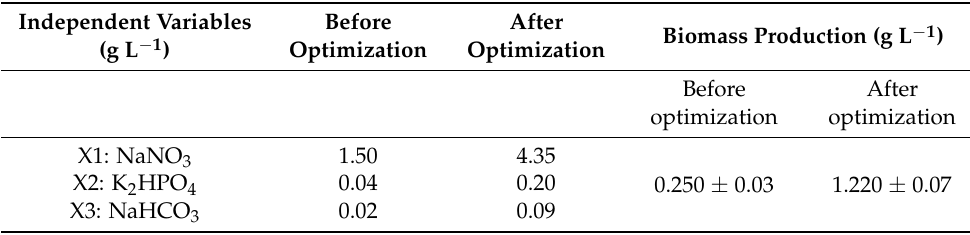
Table 3. First-stage biomass optimization of Cyanosarcina sp. AARL T020 cultivation.